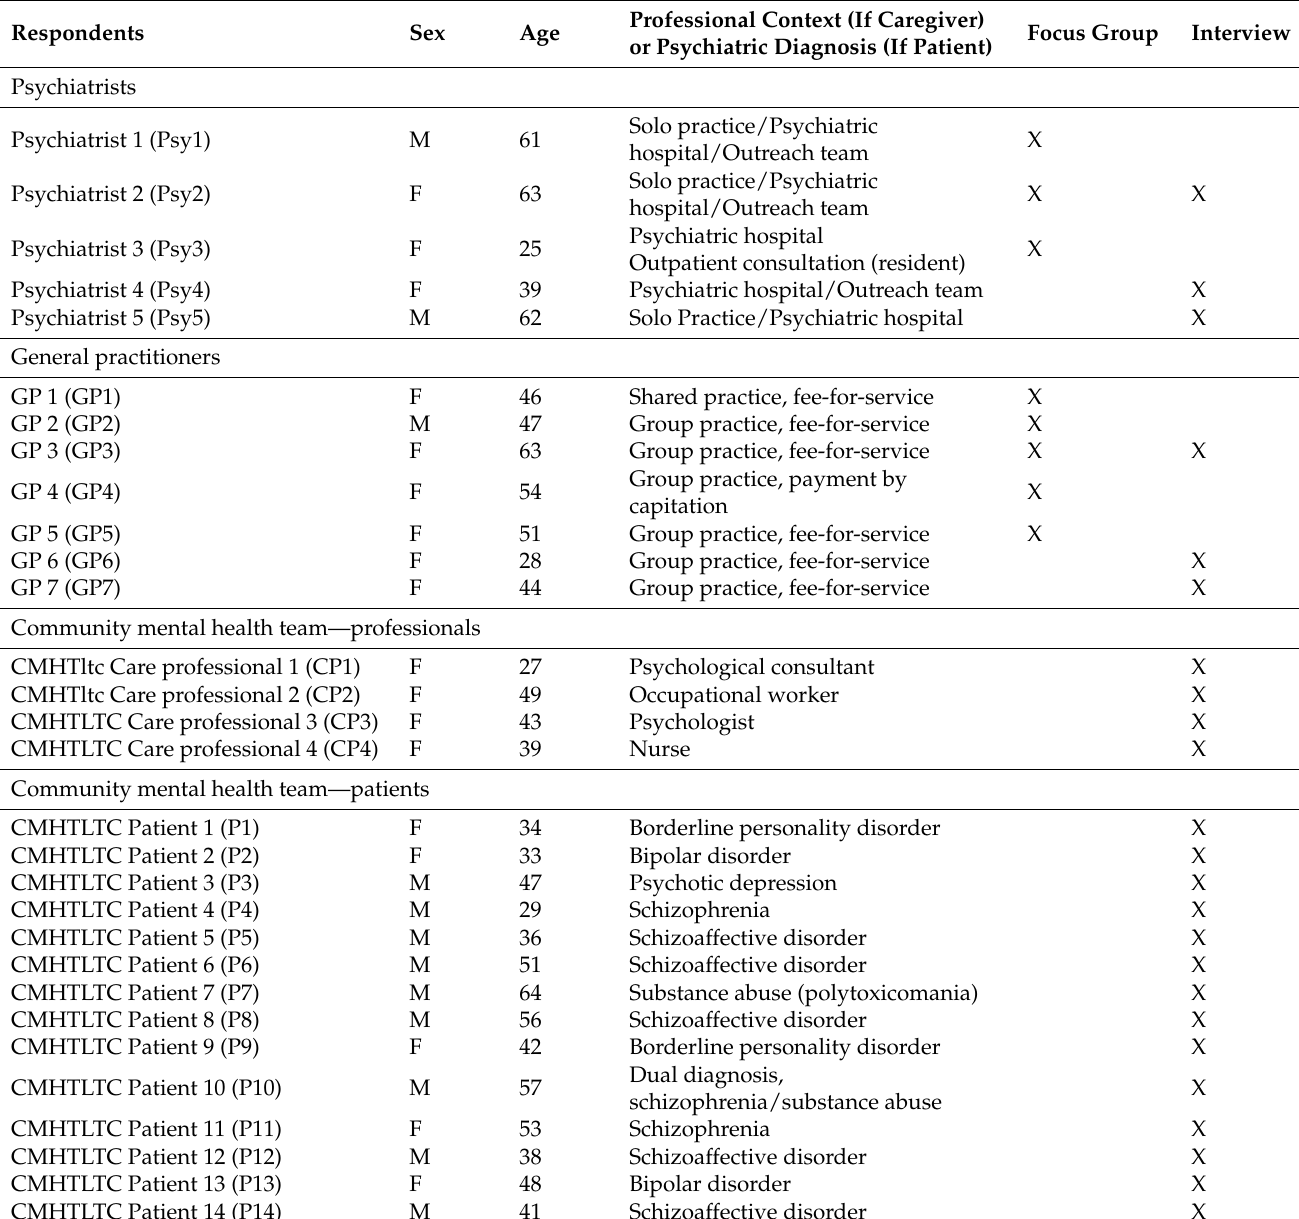
Table 1. Overview of the participants’ characteristics. (X = present at the focus group and/or